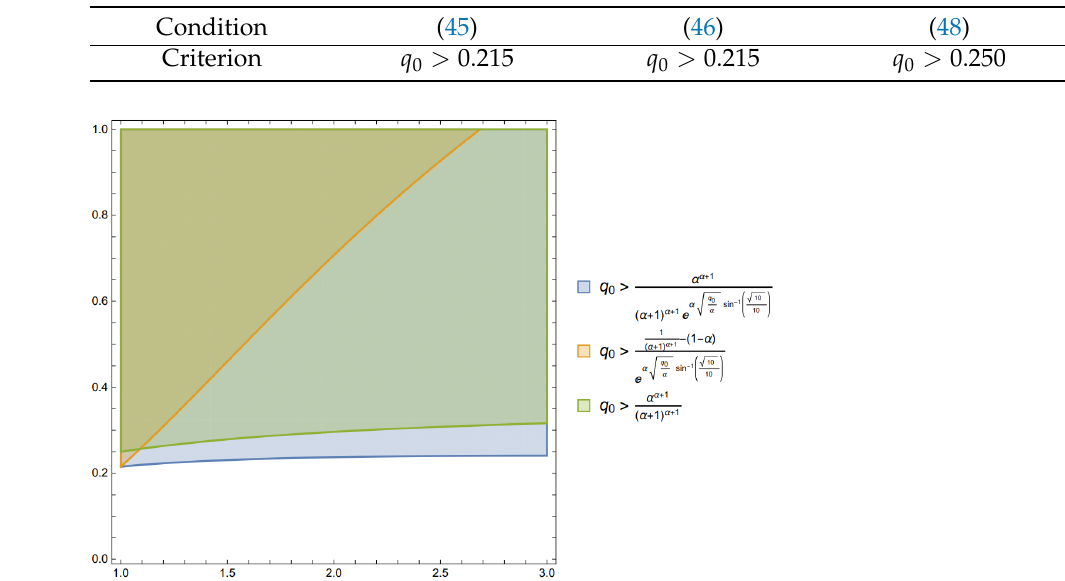
Table 1. Comparison of the different oscillation criteria of (44) with α = 1.